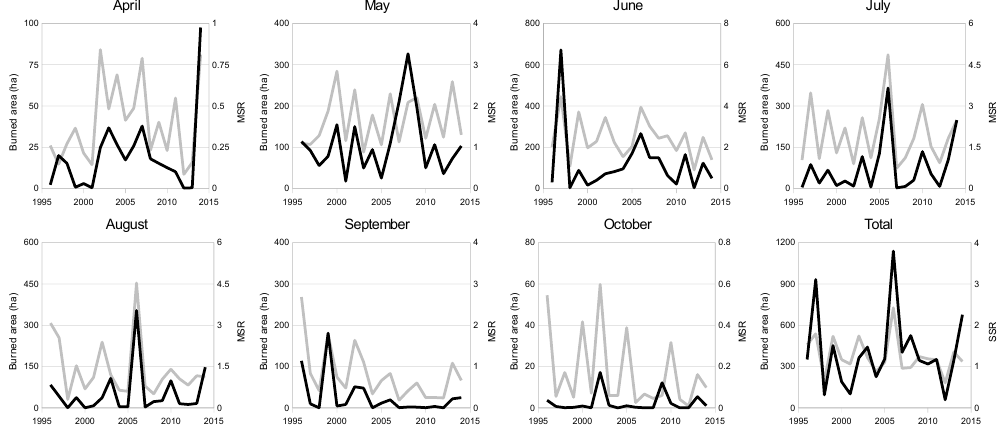
Figure 6. Burned forest area (black lines) in Finland by month and monthly severity rating (grey lines) averaged over the whole of Finland during 1996–2014.